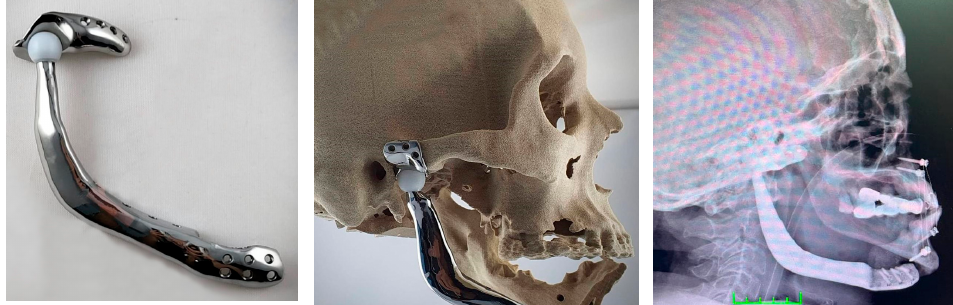
Figure 4. A 3D printed three-part custom-made prosthesis designed to address suspected tumor formation in the mandibular region of a patient (left) together with its trial mounting on a 3D printed model (middle) and an x-ray of its implantation